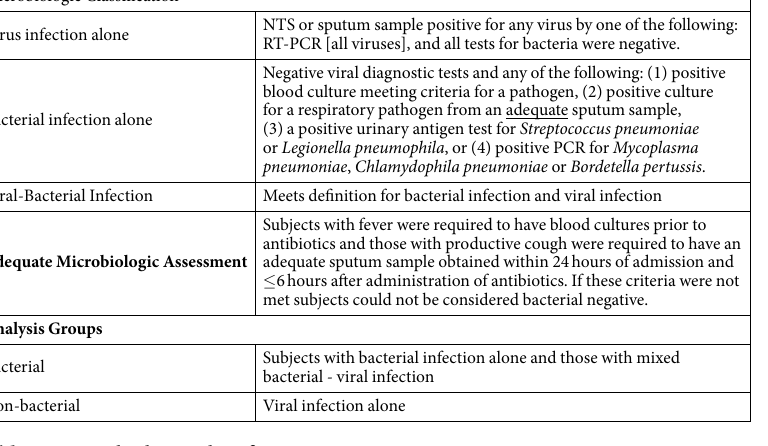
Table 1. Microbiologic Classification